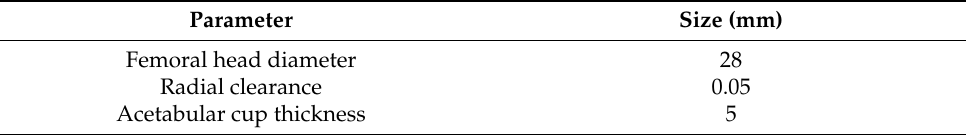
Table 1. Geometric parameters for bearing components.